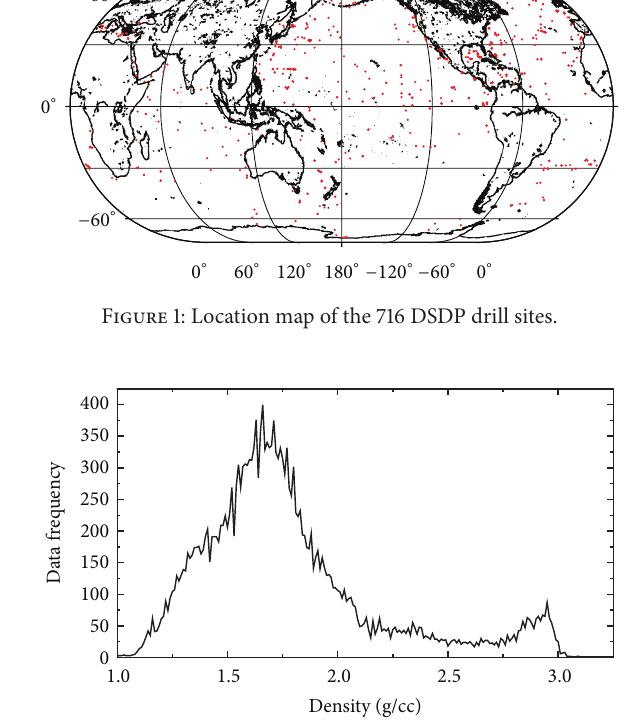
Figure 2: Histogram of the DSDP density